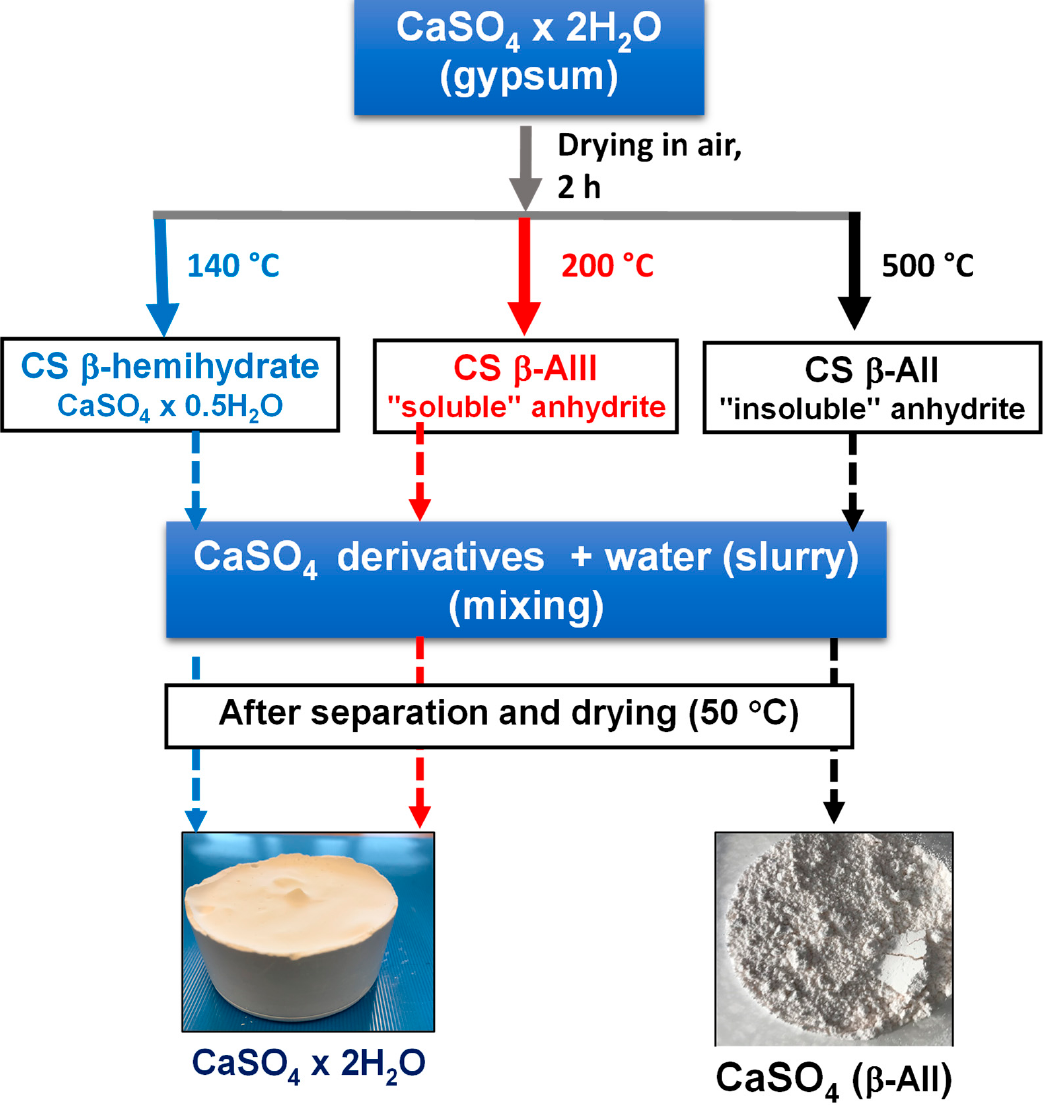
Figure 2. Experimental attempts to evidence the stability of CS β -AII by comparison to CS β -hemihydrate and CS β -AIII.